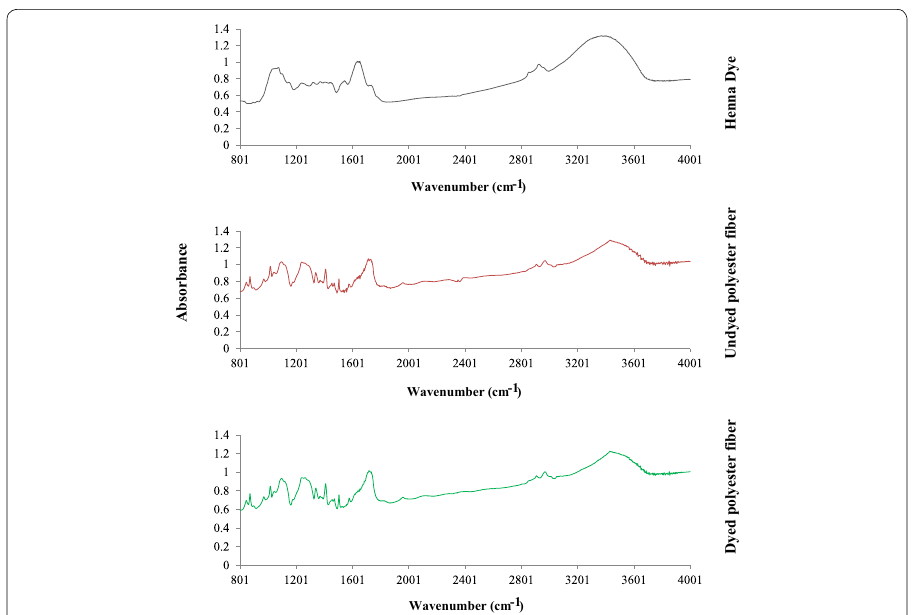
Fig. 3 FTIR absorption spectra of henna dye and polyester fiber samples at dyed and undyed